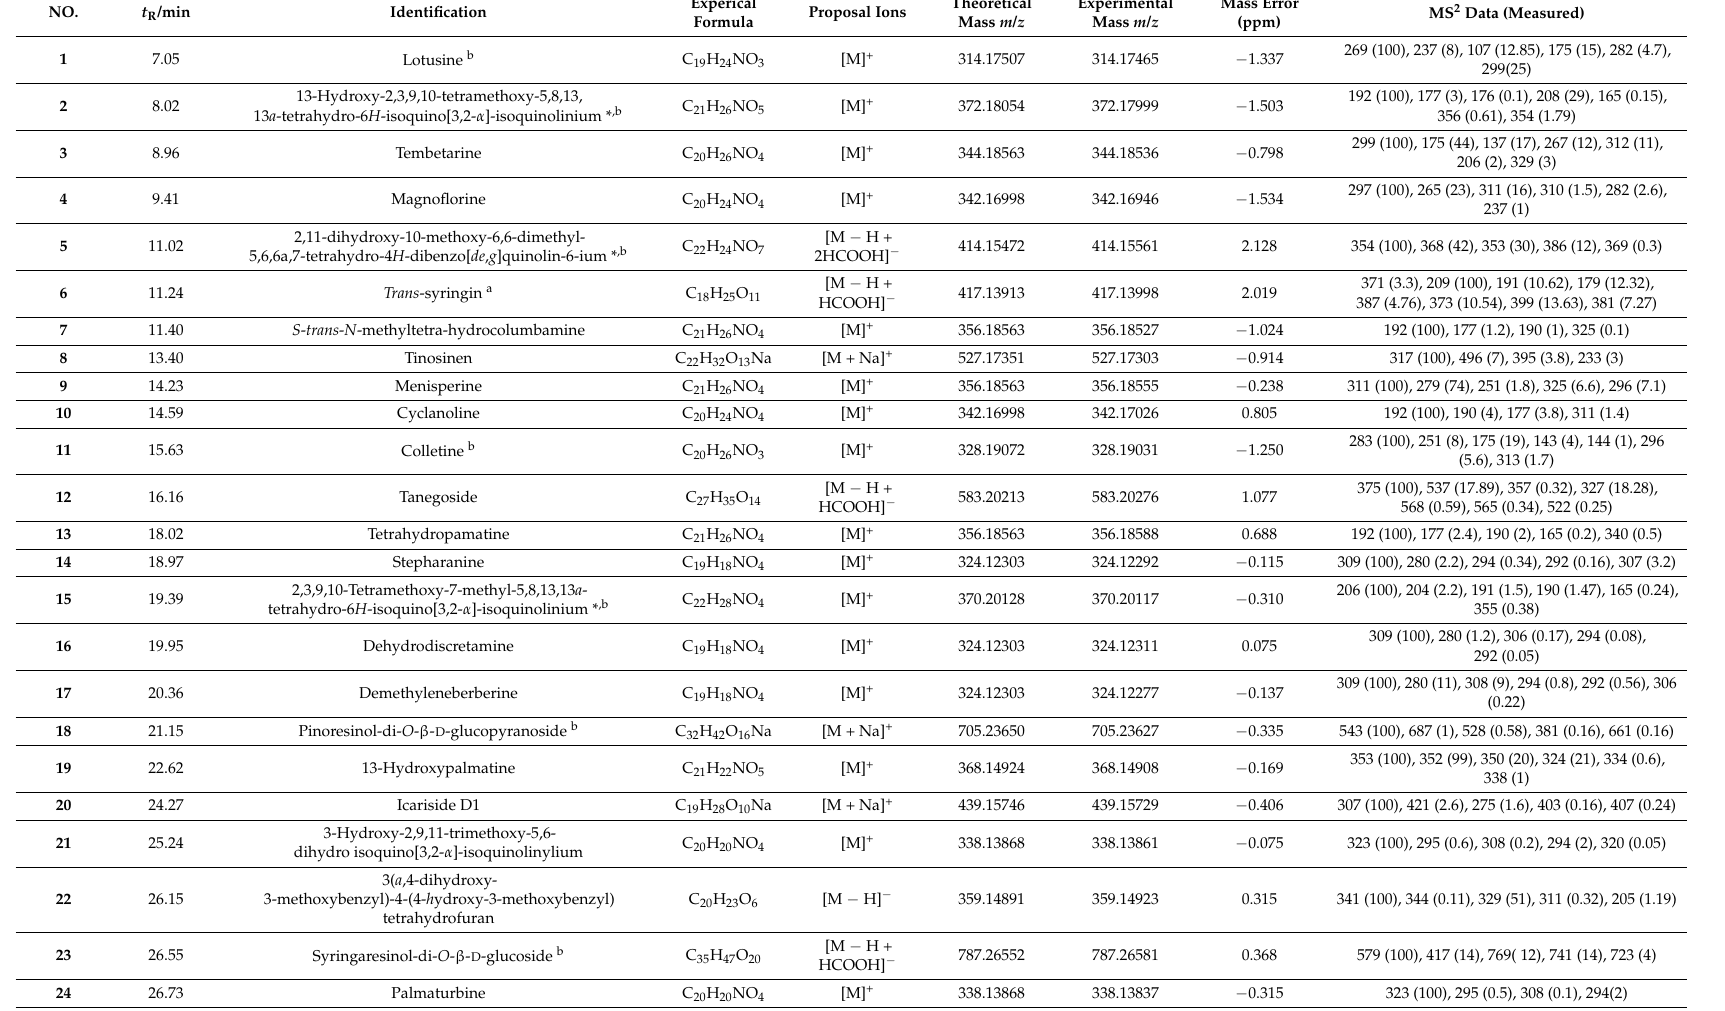
Table 1. Identification of chemical constituents of T. sinensis by